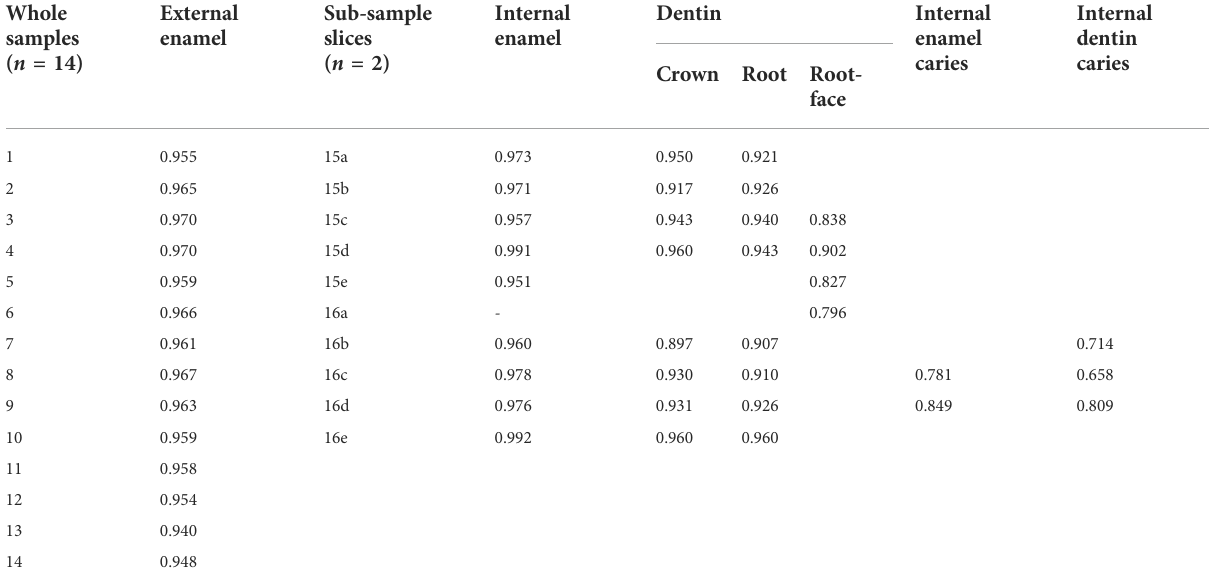
TABLE 4 Emissivity value by sample location (external or internal) and sub-sample slice with and without caries. Whole samples